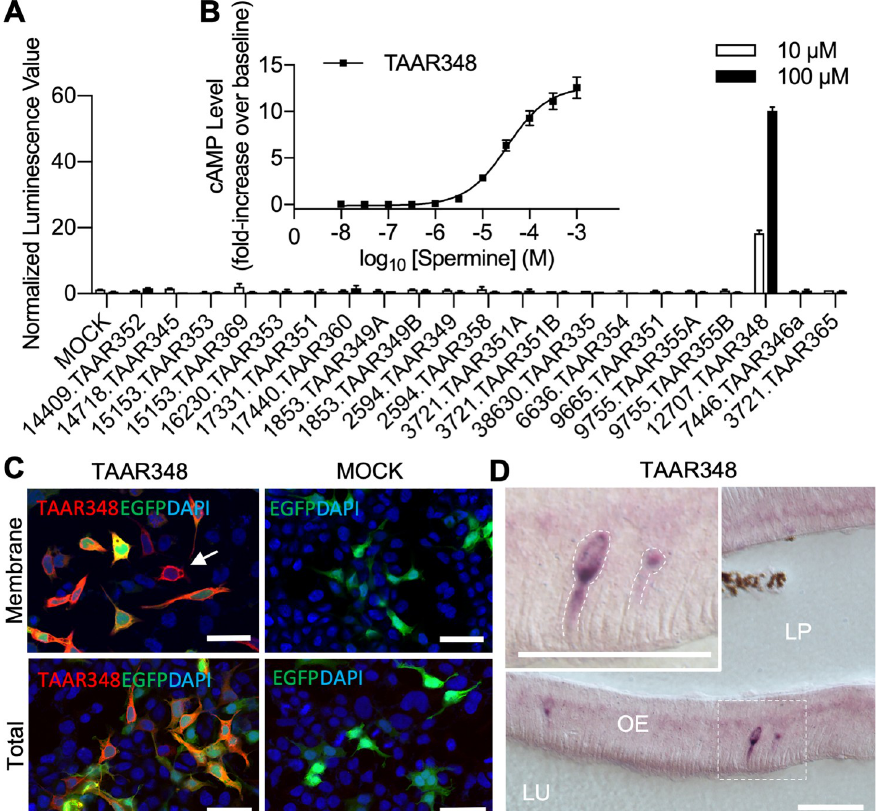
Fig 3. Spermine activated sea lamprey TAAR348. (A) HEK293T cells were incubated with TAAR plasmids or mock (empty vector) along with a CRE-luciferase reporter vector for 48 hours and subsequently stimulated with 10 or 100 μ M spermine for 4 hours. Luciferase activity was indicated by luminescence value and was normalized to the response from the control stimuli DMSO (mean ± SEM, n = 2). (B) As an inset to (A), (B) shows spermine-induced cAMP production in HEK293T cells expressing TAAR348. The cAMP levels were measured with a TR-FRET assay and normalized to the cAMP level in buffer-treated cells (mean ± SEM, n = 5). Fold increase over basal was calculated as [(measured cAMP − basal cAMP) � basal cAMP] − 1. (C) TAAR348 targeted to HEK293T cell membrane as shown by the immunostained Rho-tag antibody (red) for total (bottom panel, with permeation using Triton X-100) or membrane-bound (top panel, without permeation) expression. Receptors located on the cell surface appeared as red rings around the nucleus (denoted with arrow). The nucleus was counterstained with DAPI (blue). EGFP was used as the negative control to evaluate transfection efficiency (green). Scale bar: 50 μ m. (D) Representative olfactory receptor neurons expressing taar348 (purple), labeled with a DIG-labeled antisense RNA probe in a cross-sectional view of the main olfactory epithelium of an adult female sea lamprey. The section was counterstained with Nuclear Fast Red. Scale bar: 50 μ m. Underlying data are available in S1 Data. cAMP, cyclic-adenosine monophosphate; CRE, cyclic-adenosine monophosphate response element; DIG, digoxigenin; EGFP, enhanced green fluorescent protein; HEK293T, human embryonic kidney 293T; LP, lamina propria; LU, lumen; OE, olfactory epithelium; TAAR, trace amine-associated receptor; TR-FRET, time-resolved fluorescence energy